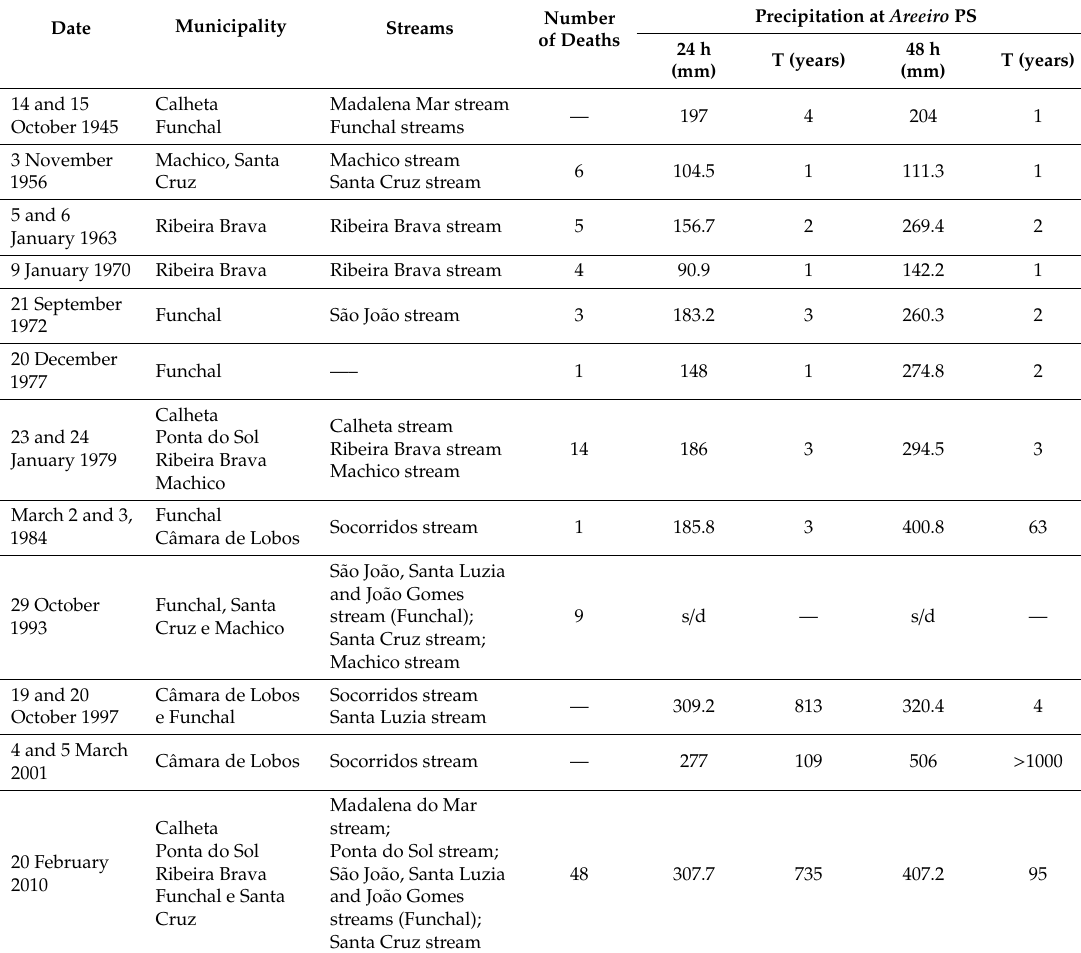
Table 7. Intense precipitation events, mass movements and flash floods that occurred between 1945 and 2011 on the southern slope of the island of